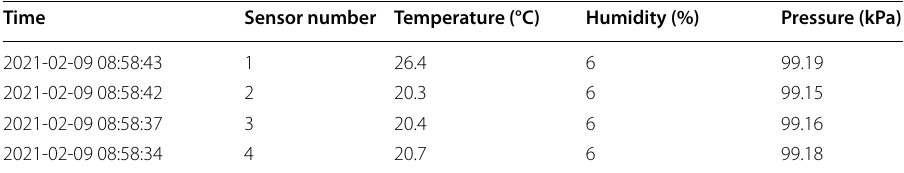
Table 1 Sample of sensor data set